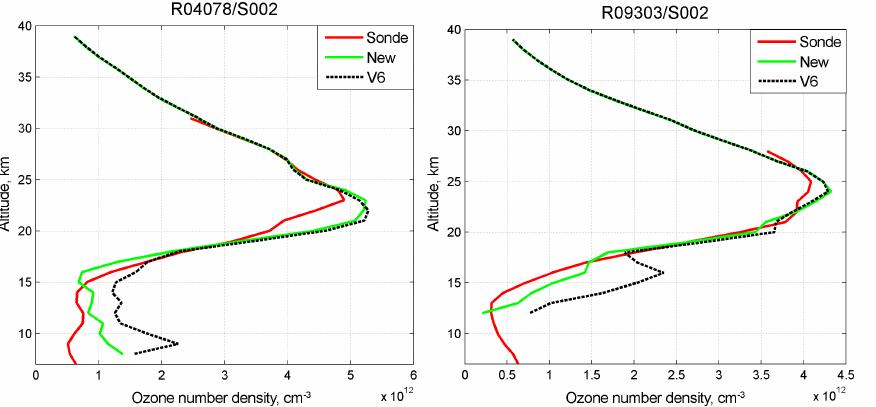
Figure 8. Ozone profiles for occultations R09303/S002 (left) and R04078/S002 (right) for the ALGOM2s retrievals (“new”) compared to V6 and ozone sonde profiles at